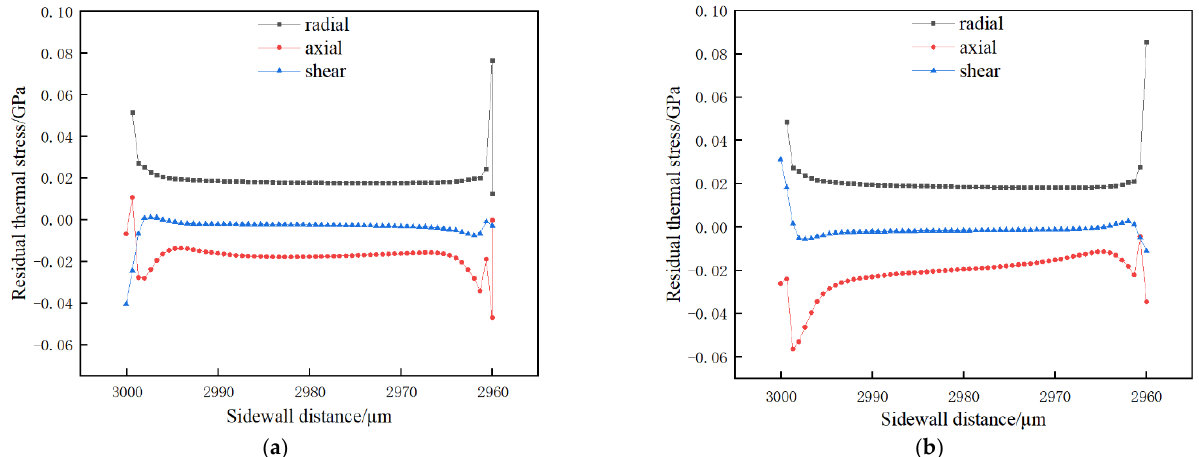
Figure 11. Distribution of residual thermal stress along the depth of the sidewall ( a ) Left sidewall, ( b ) Right sidewall of the M2S2 crack at the “reduce to room temperature” situation.